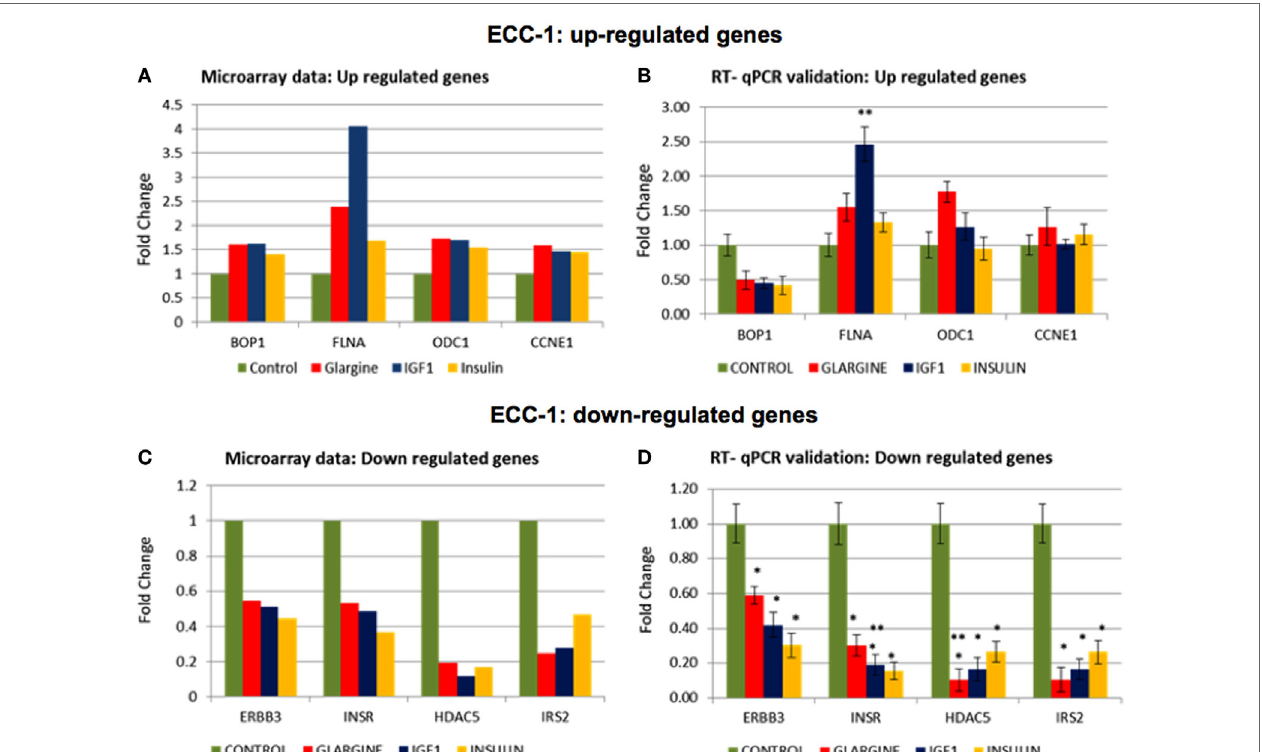
FigUre 8 | Real-time quantitative polymerase chain reactions (RT-qPCR) validation of the microarray data for selected up- and downregulated genes in ECC-1 cells. (a) Microarray results of four selected upregulated genes; (b) relative expression of the upregulated genes by RT-qPCR. (c) Microarray results of four selected downregulated genes; (D) relative expression of the downregulated genes by RT-qPCR. Lower fold-change values were obtained in the RT-qPCR validation compared to microarray assays. RT-qPCR was done in triplicate and the ratio was calculated relative to the reference gene actin. Statistical analysis was done by